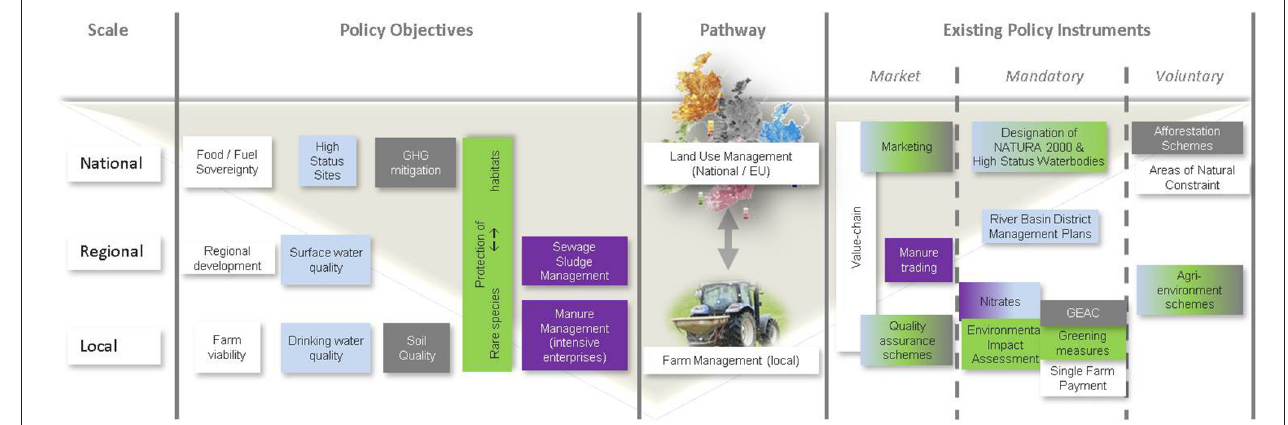
FIGURE 7 | Inventory of policy objectives and policy instruments of relevance to the management of soil functions. The color coding refers to the soil functions of relevance to each of the objectives and instruments: white, primary production; blue, water purification and regulation; black, carbon storage and regulation; green, provision of a habitat for biodiversity; purple, cycling of